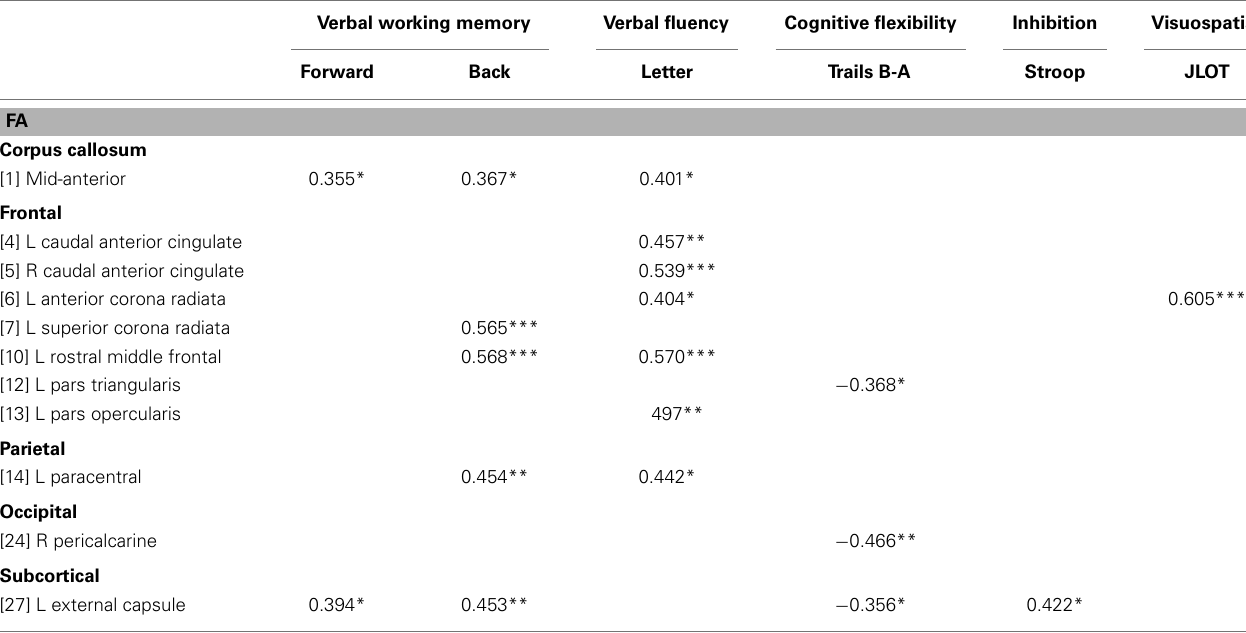
Table 4 | Partial correlations of FA with cognitive measures in Parkinson’s